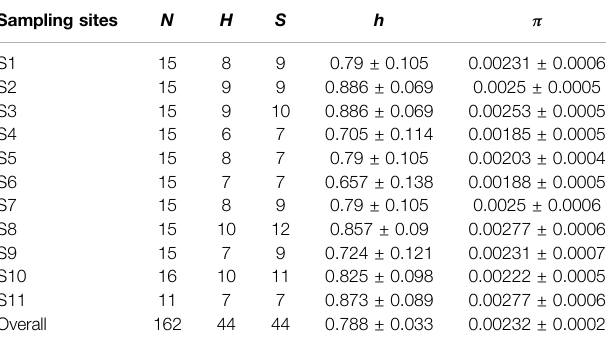
TABLE 1 | Descriptive statistics of genetic diversity of Evynnis cardinalis sampled from Beibu Gulf based on COI sequence data. Sampling sites